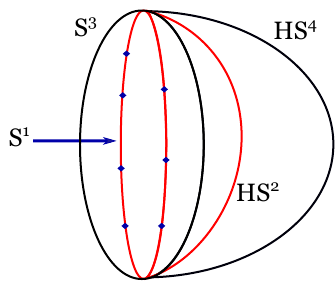
Figure 1 . In the sphere background formulation, the 4d theory lives on HS 4 , the 2d protected sector lives on a great HS 2 ⊂ HS 4 . The boundary of HS 2 is a great circle S 1 ⊂ S 3 with some operator